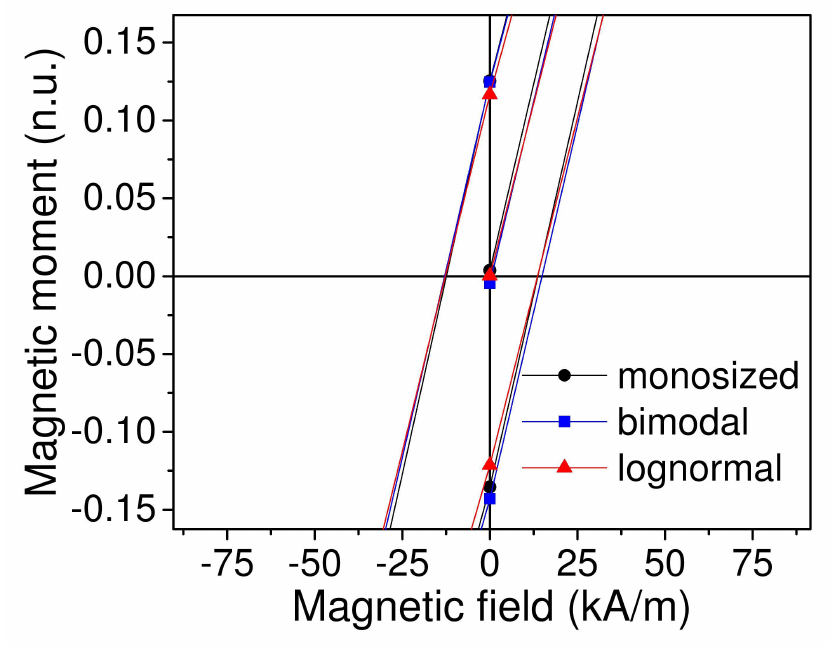
Figure 7. Low-field region showing the open hysteresis